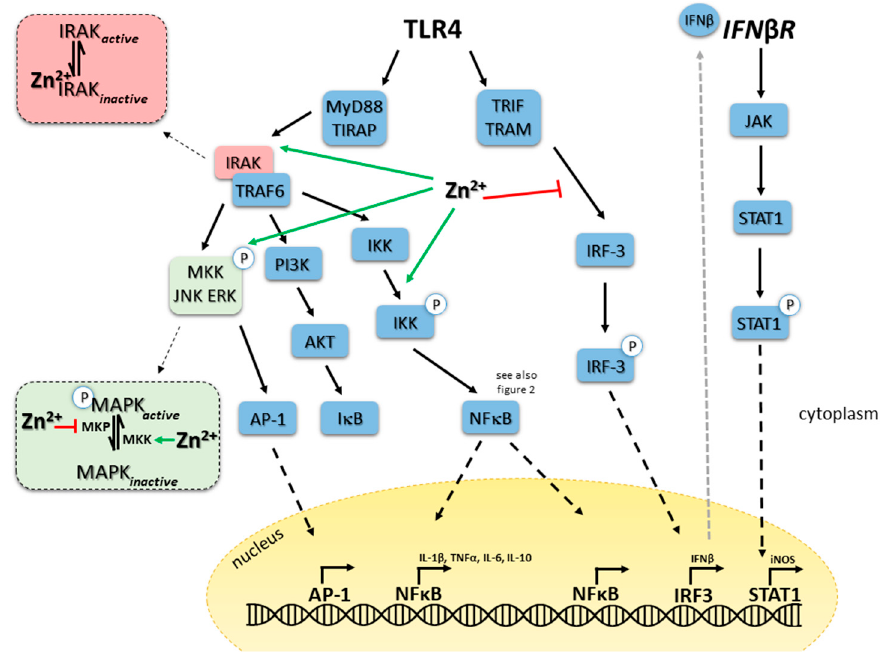
Figure 1. Zinc in TLR4 triggered signaling, illustrating explanations in the text. Black arrow: activation, green arrow: activating function of zinc, red T bar: inhibiting function of zinc, black dotted arrow, translocation of the molecule to nucleus, grey dotted arrow: secretion of the molecule.